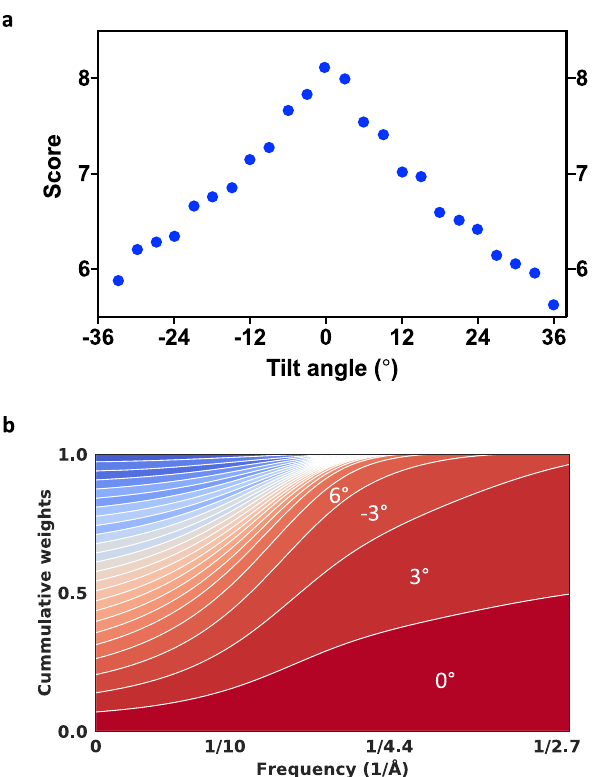
Fig. 4 Self-tuning exposure weighting based on assigned particle scores. a Average similarity scores calculated over individual particle projections and plotted as a function of the tilt-angle revealing the expected characteristic of the dose-symmetric scheme showing higher quality data obtained at the lower tilts. b 2D plot showing the cumulative contribution of individual tilts to the 3D reconstruction as a function of spatial frequency. Each colored band represents one tilt. The high frequency information is contributed mostly by lower tilts which are also exposed fi